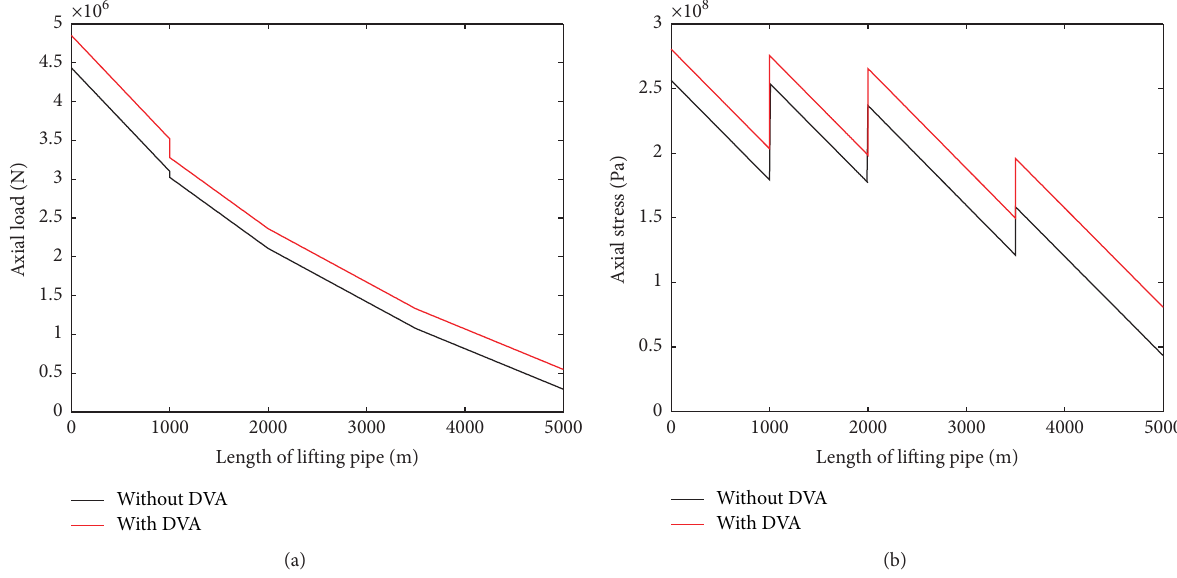
Figure 14: Gravity load and stress with/without DVA. (a) Axial load. (b) Axial